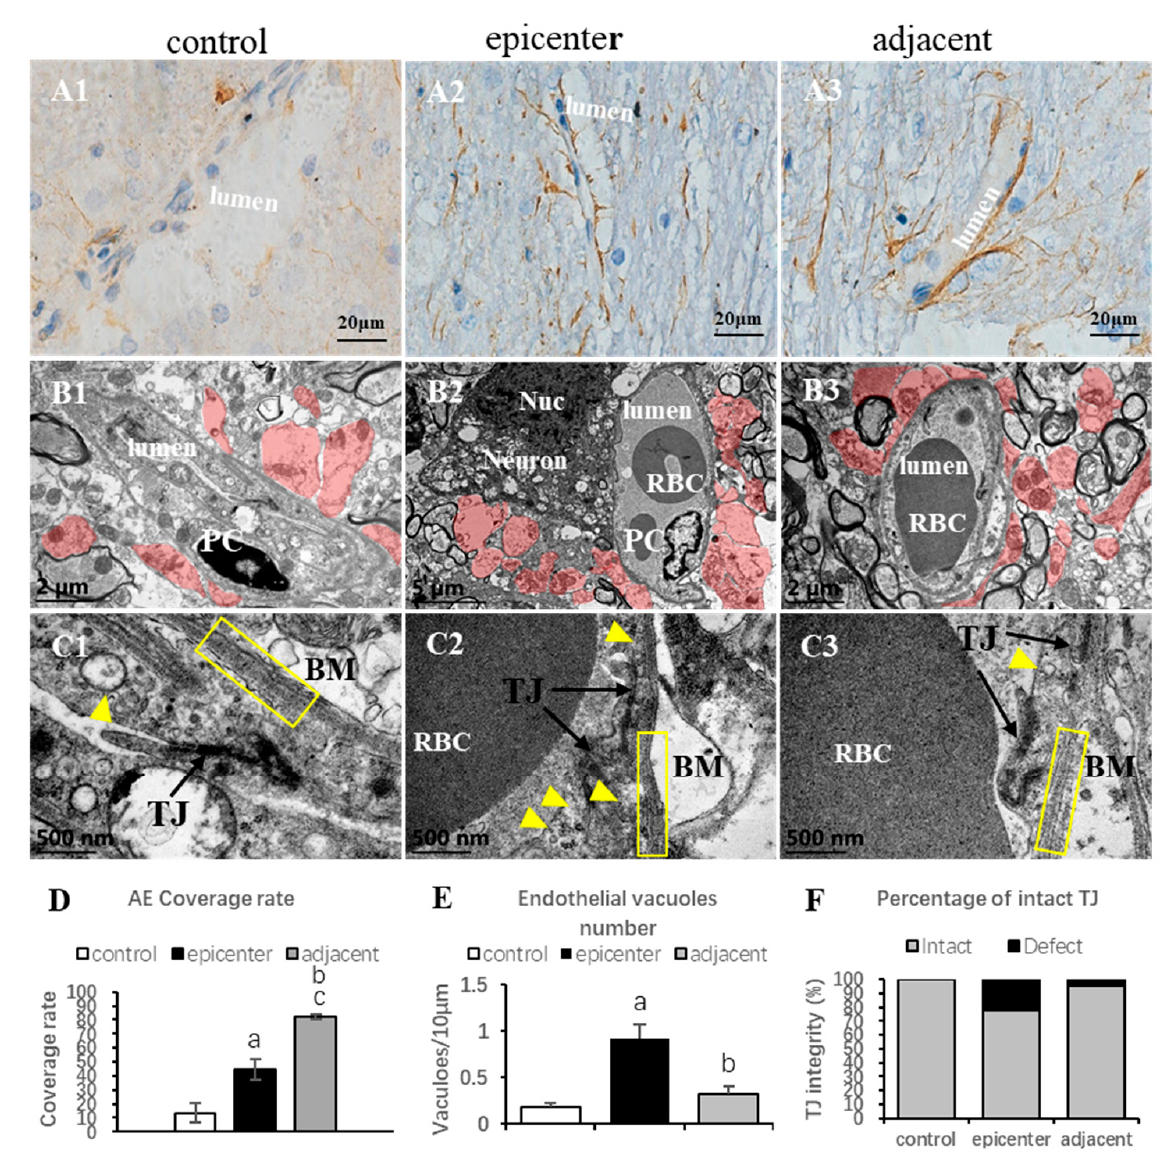
Figure 7. Microvascular compensation in the adjacent level. ( A1 , A2 , A3 ) Perivascular astrocyte endfeet. ( A1 ) Sparse astrocyte endfeet in the VH of the control group. ( A2 ) Astrocyte endfeet detach from the endothelial cells of microvessels in the compressive epicenter. ( A3 ) Proliferated astrocyte endfeet in the adjacent level. ( B1 – B3 ) Neurovascular ultrastructure. ( B1 , C1 ) Normal microvascular components including distinct endothelium, high electronic density TJ and PC) nucleus, clear lamina of BM and surrounded perivascular astrocytic endfeet (red shadow) in control group. Homogeneous electron density. ( B2 , C2 ) NVU degeneration in the compressive epicenter, including collapsed microvascular wall, disorganized BM and loss of TJ integrity, neuron degeneration and apoptosis, formation of phagolysosomes and autophagic vacuoles. ( B3 , C3 ) Restoration of microvascular microstructure. ( D ) Significant increase of astrocytic endfeet both in the compressive epicenter and adjacent level. ( E ) Significant decrease of vacuoles number in endothelial in adjacent level. ( F ) Restoration of TJ integrity in adjacent level. PC (pericyte), Nuc (nucleus), TJ (tight junction),